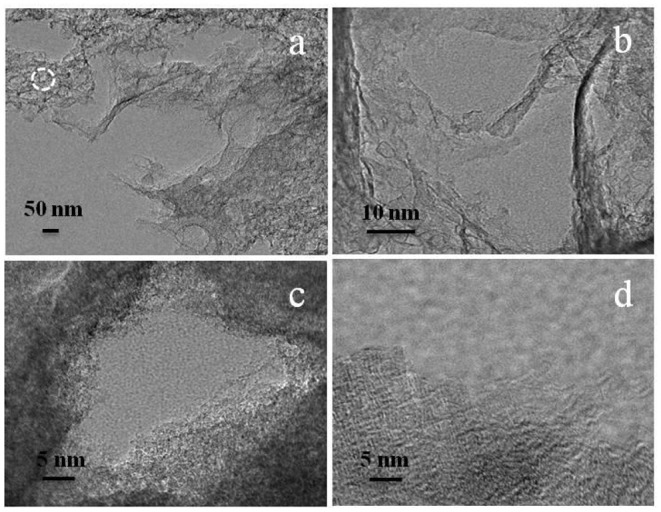
TEM images of HPCs*-5-900 showing: (a) edges of carbon, (b) randomly carbon walls, (c) site-occupying region, and (d) micropore-enriched edges after carbon dioxide gas activation.